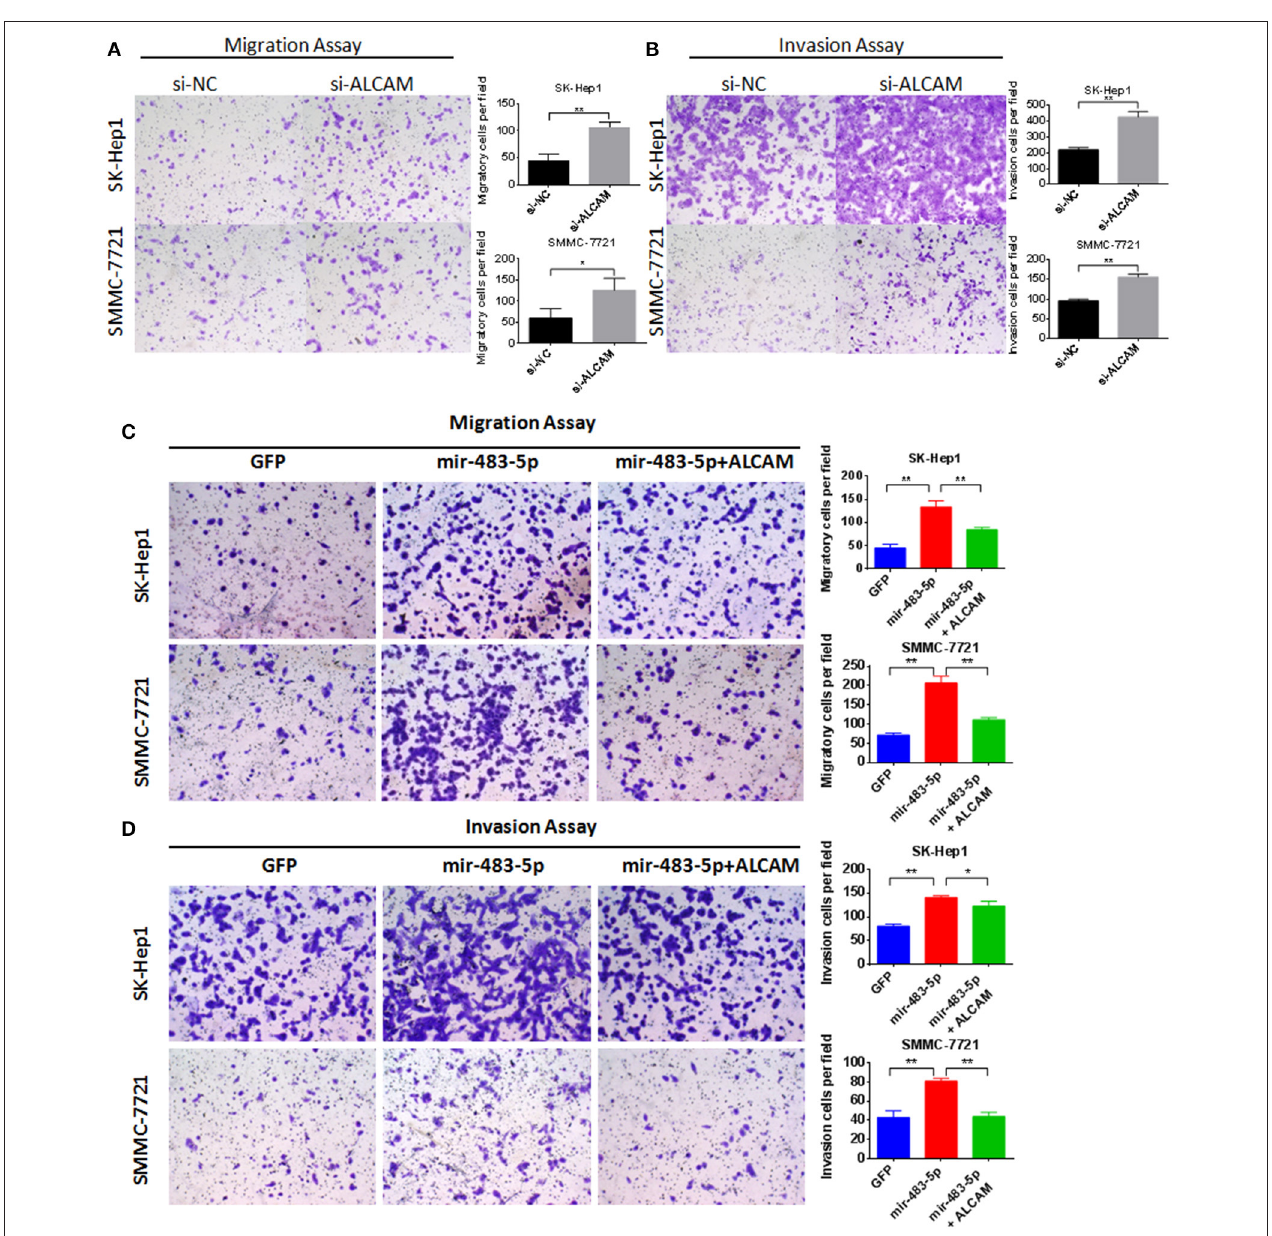
FIGURE 5 | Knockdown of ALCAM can promote HCC cell migration and invasion. Restoration of ALCAM reverses miR-483-5p-mediated HCC cell migration and invasion. (A) Transwell migration assay of SK-Hep1 and SMMC-7721 showed transfection of ALCAM siRNAs promoted cell migration. (B) Transwell invasion assay showed transfection of ALCAM siRNAs promoted cell invasion. (C) The migration of HCC cells induced by miR-483-5p was restored via ALCAM re-introduction. (D) The invasion of HCC cells induced by miR-483-5p was restored via ALCAM re-introduction. * p < 0.05; ** p < 0.01 ×